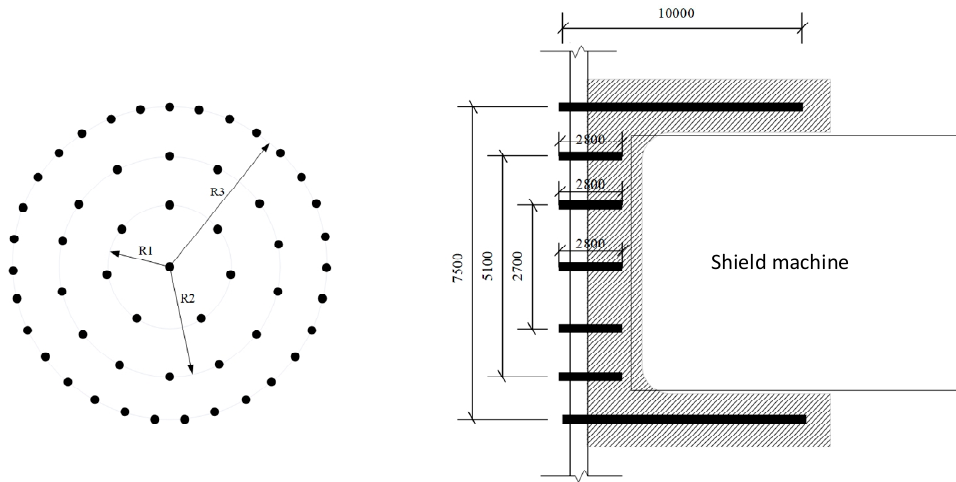
Figure 2. Layout diagram of freezing pipes (unit: mm).